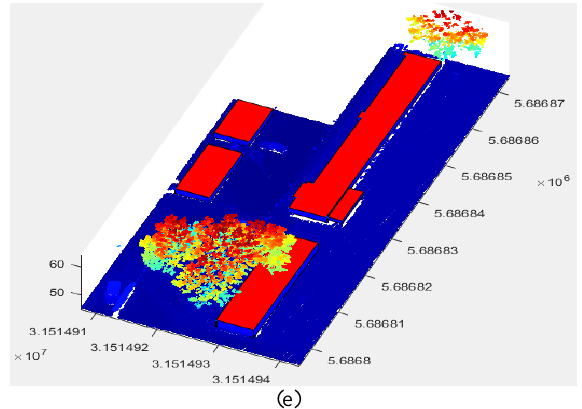
Figure 9. a) Point cloud, b) Point cloud of buildings, c)